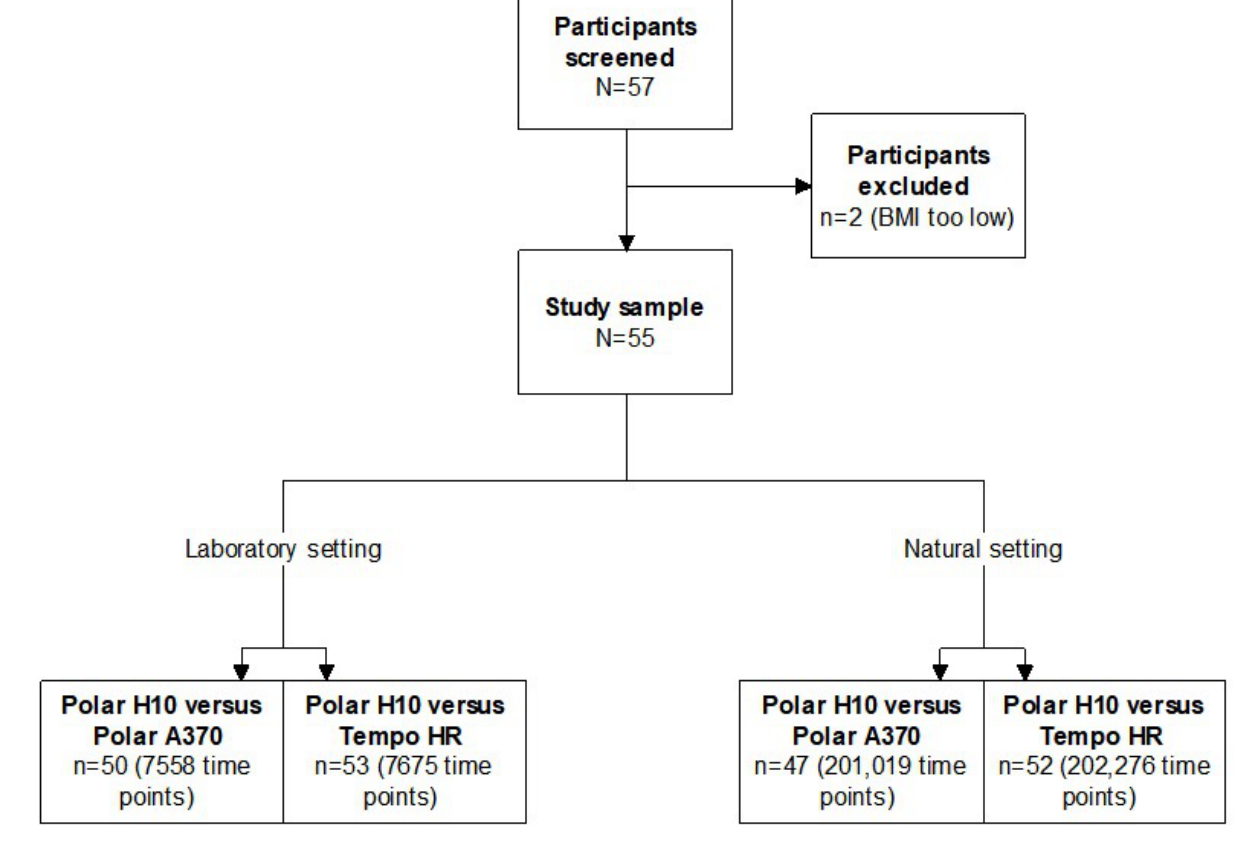
Figure 1. Data analysis flow showing participants in analysis (n) and number of matched heart rate time points. BMI: body mass index; HR: heart